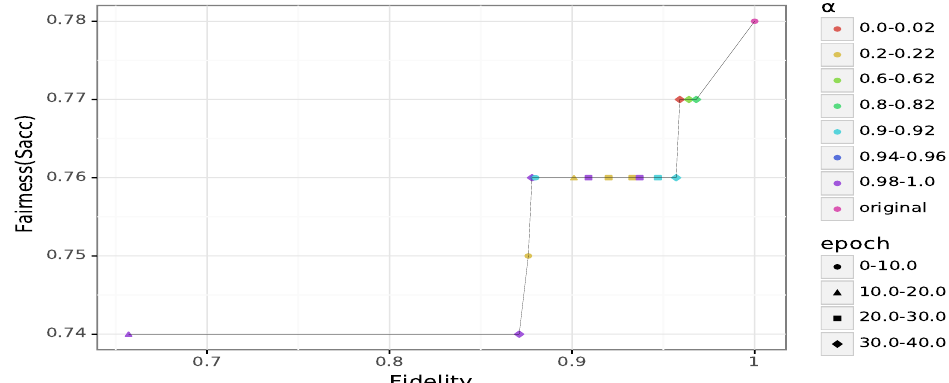
Figure 5. Fidelity-fairness trade-off on German Credit. Each point represents the minimum possible sAcc of all the external classifiers.